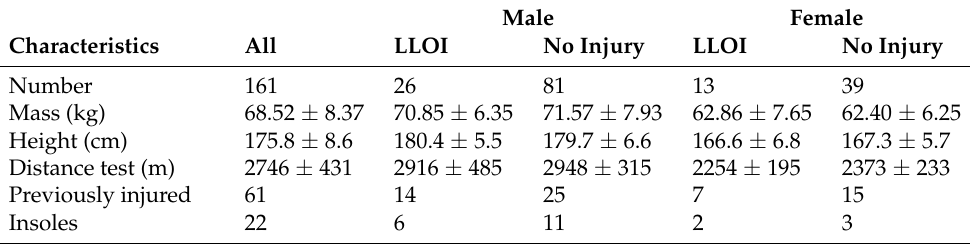
Table 3. Descriptive characteristics of all participants included in the analysis. Values of continuous variables are expressed as mean ± standard deviation. Discrete variables are expressed as the number of participants with the characteristic. Male Female